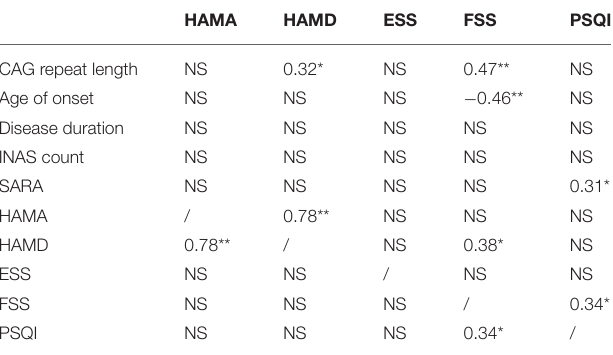
TABLE 3 | Correlations between non-motor symptoms and clinical variables in SCA3